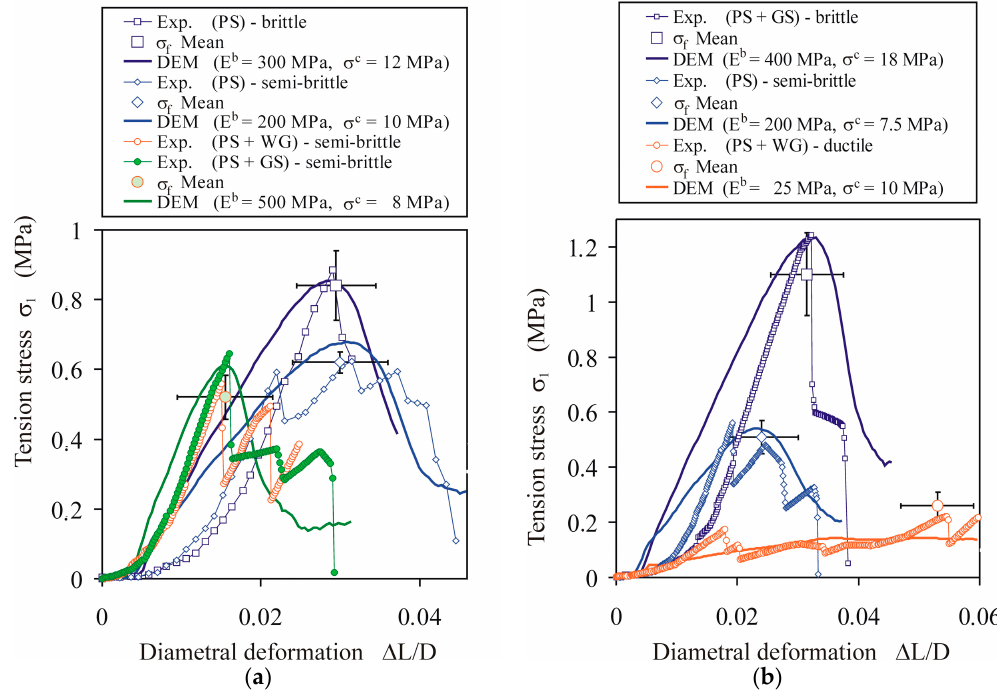
Figure 9. Effects of additives and pretreatment on the σ 1 ( Δ L / L ) relationships during the diametral compression of the PS agglomerates: ( a ) without steaming and ( b ) with steaming. The bars indicate the standard deviation.